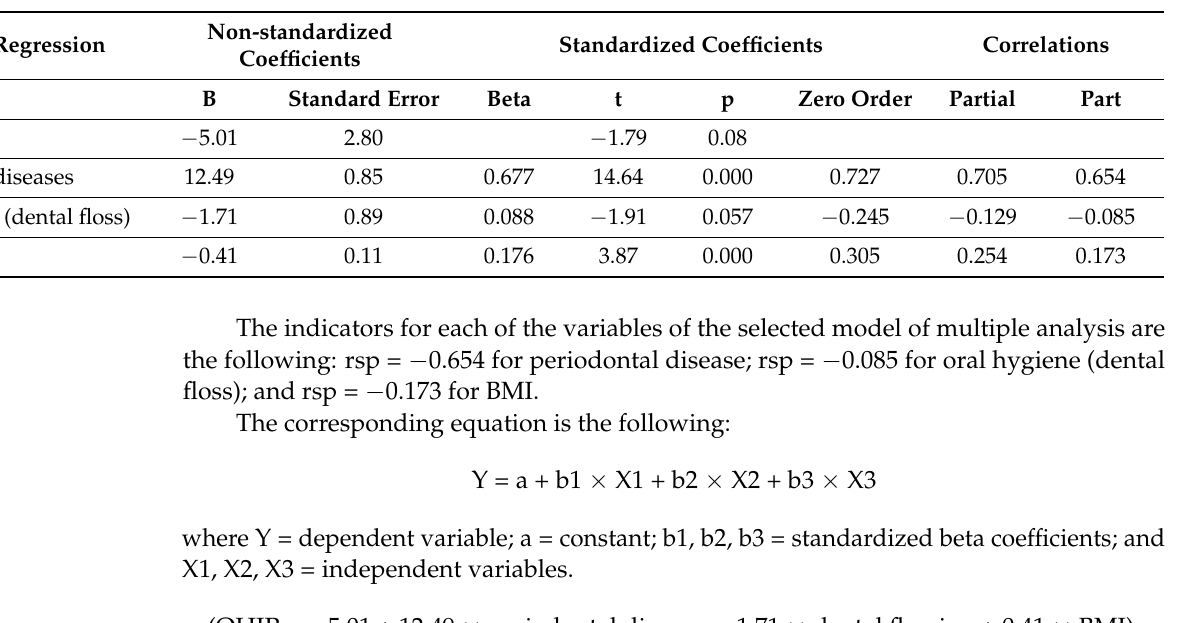
Figure 4. The normality of the standardized residual distribution compared to the deviations from the normal (Mean = − 1.13 × 10 15 Std. Dev. = 0.993 N = 221). Table 4. Beta-standardized coefficients indicating a significant influence of the independent variables on the dependent variable (quality of